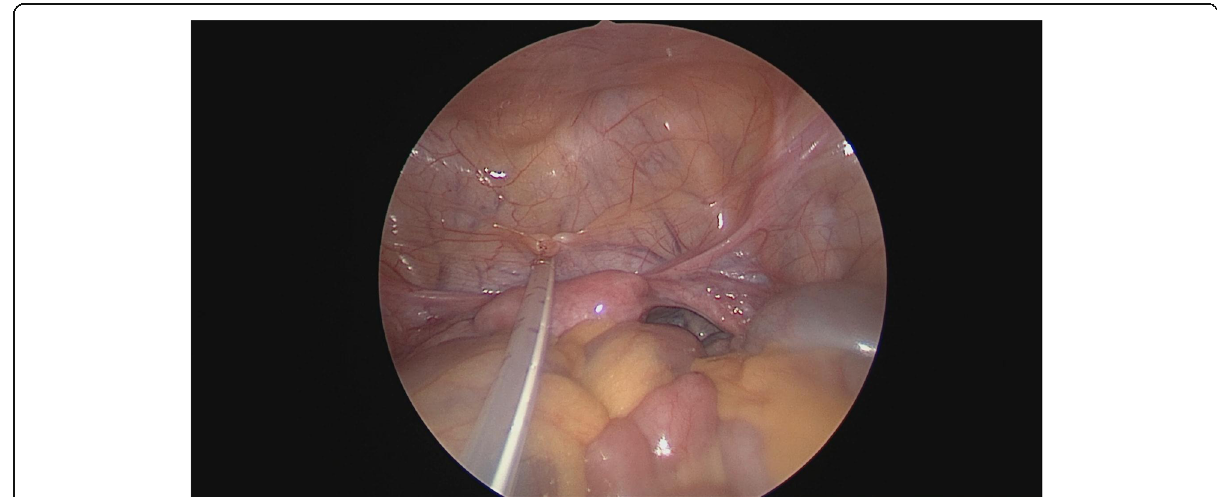
Fig. 4 Fixation of catheter tip at pelvis of